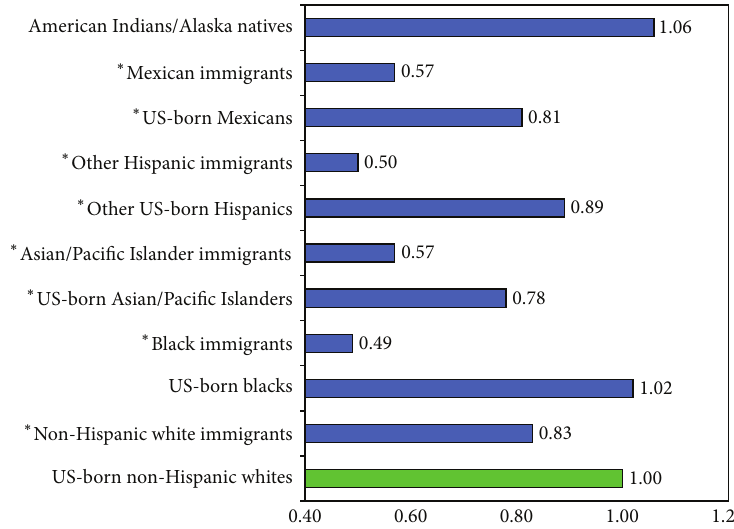
Figure 2: Ethnic-immigrant differentials in US all-cause mortality (hazard ratio or relative risk): The US National Longitudinal Mortality Study, 1980–1998 ( 𝑁 = 304, 594 ). Adjusted by Cox regression for age, sex, marital status, household size, education, family income, employment status, and rural/urban residence. ∗ 𝑃 < 0.05 . US-born non-Hispanic whites were the reference group. Source: updated analysis of data presented in [32].